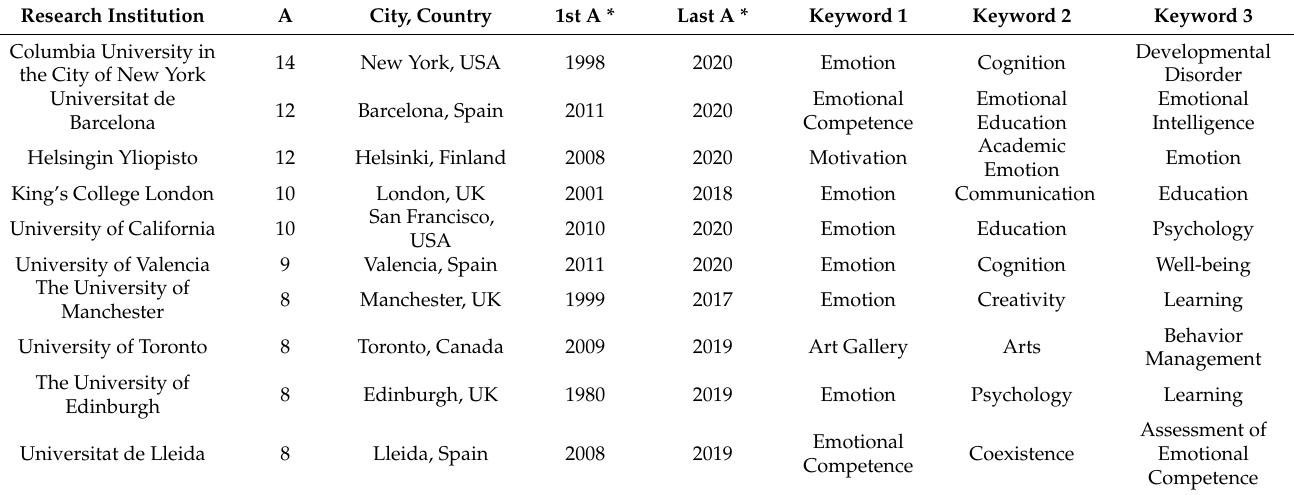
Table 2. Top 10 research institutions